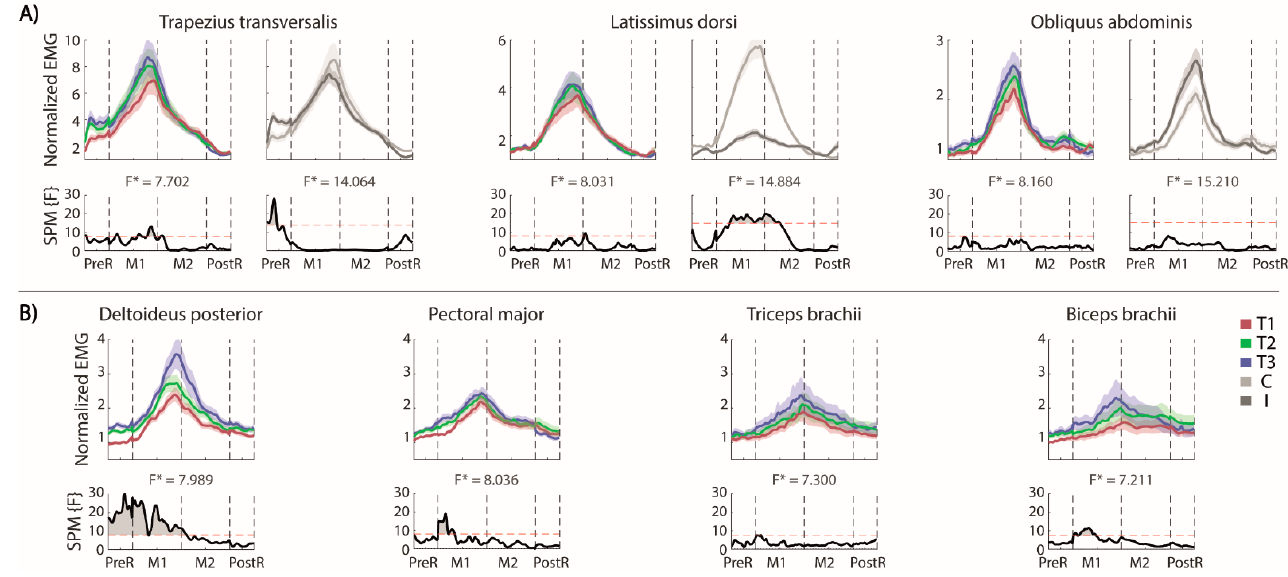
Figure 3. MFRT in the forward direction. ( A ) Bilateral EMG activity of the trunk muscles: for each pair of muscles we reported their envelopes (top) and the statistical analysis (down, the significance difference is the part of the curve above the dashed red line) separated for the trials’ repetition (left, the mean activity of the muscles pair is reported in red, green and blue for T1, T2 and T3, respectively) and the body sides (right, the mean activity of each side is reported in lighter and darker gray for the contralesional and the ipsilesional side, respectively); ( B ) EMG activity of the contralesional arm muscles separated for the trials’ repetition and the statistical analysis (bottom). F* is the F* value from the statistical analysis.